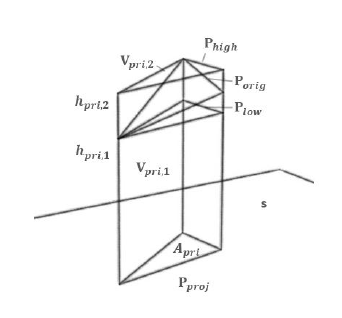
Figure 5. Geometric situation for the distance measure based on the volume between the mesh triangle P orig and its projection P proj onto the surface plane s .